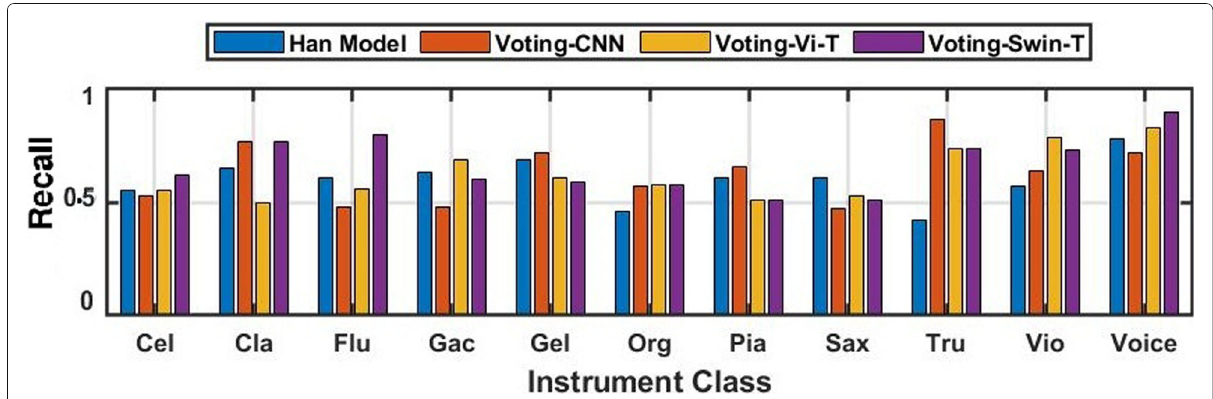
Fig. 4 Instrument-wise recall for experiments with data augmentation